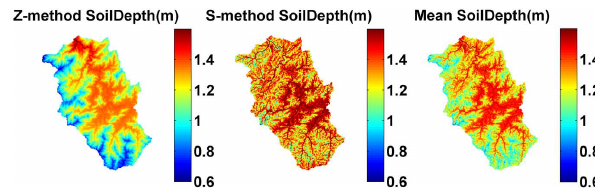
Fig. 6. The spatially varying soil depth estimated by two simple methods, and the ultimate soil depth used in this study averaging the two estimated soil